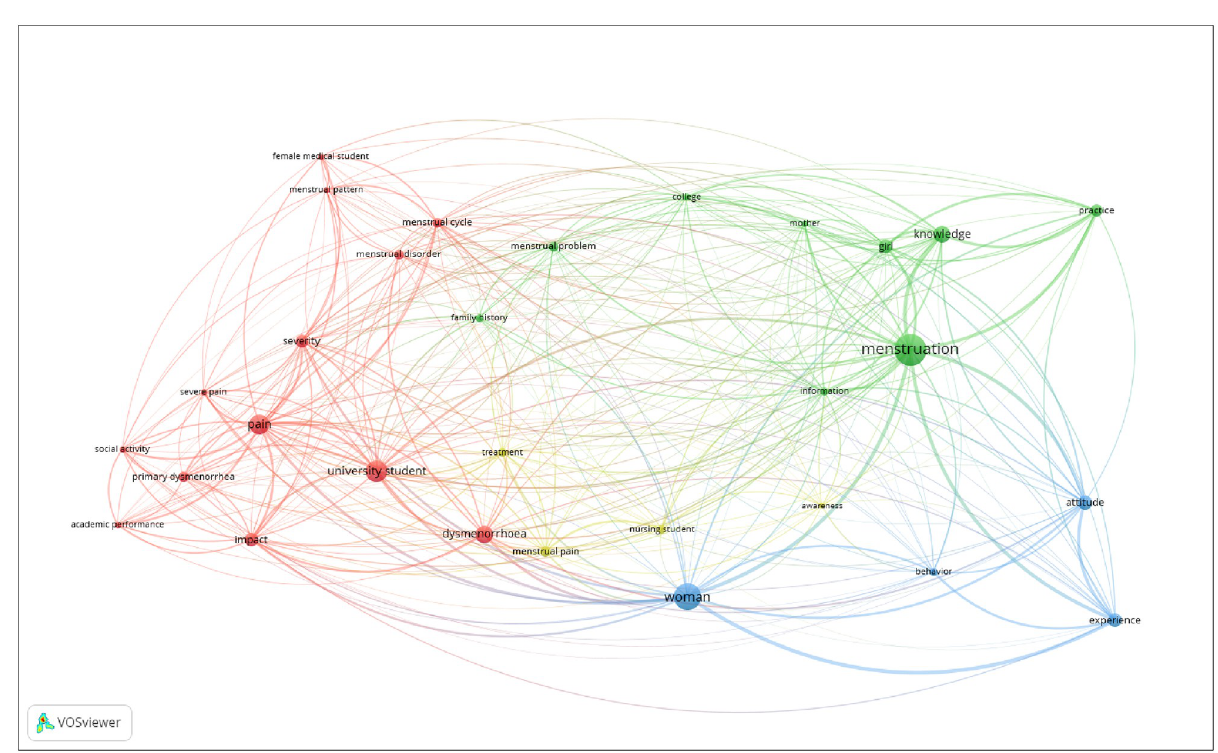
Fig 2. Network map of keyword co-occurrences across the included